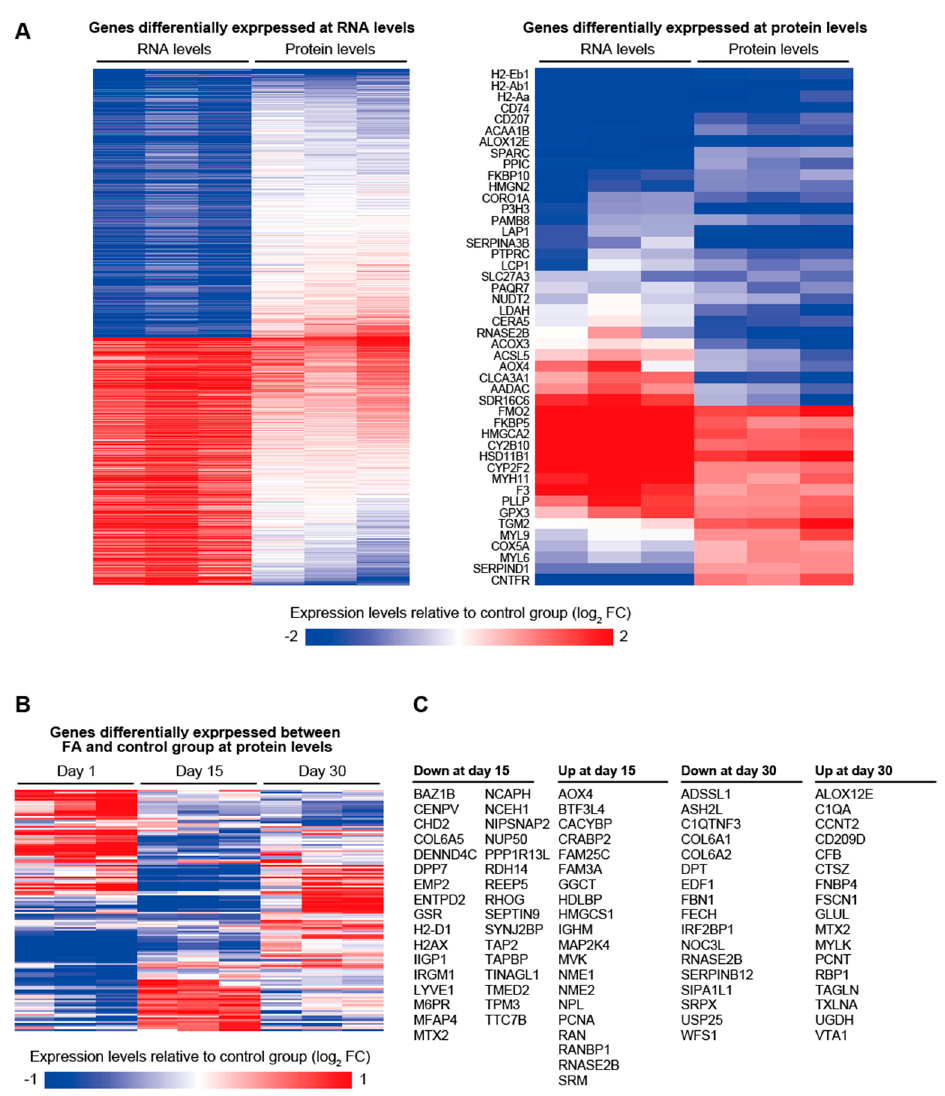
Figure 3. The effects of FA treatment on the proteome of the mouse dorsal skin. ( A ) The heatmaps represent the relative expression levels of genes in 1 day post-FA-treated skin samples compared to 1 day post-vehicle-treated skin samples. The left and right heatmaps show the relative expression levels of genes whose expression was significantly affected by FA treatment at RNA and protein levels, respectively. ( B ) The heatmap represents the relative protein expressions of genes that were significantly differentially expressed between FA-treated and control skin samples at 1, 15, or 30 days after the treatments. ( C ) List of genes that were significantly differentially expressed between FA-treated and control skin samples at 15 or 30 days after the treatments.